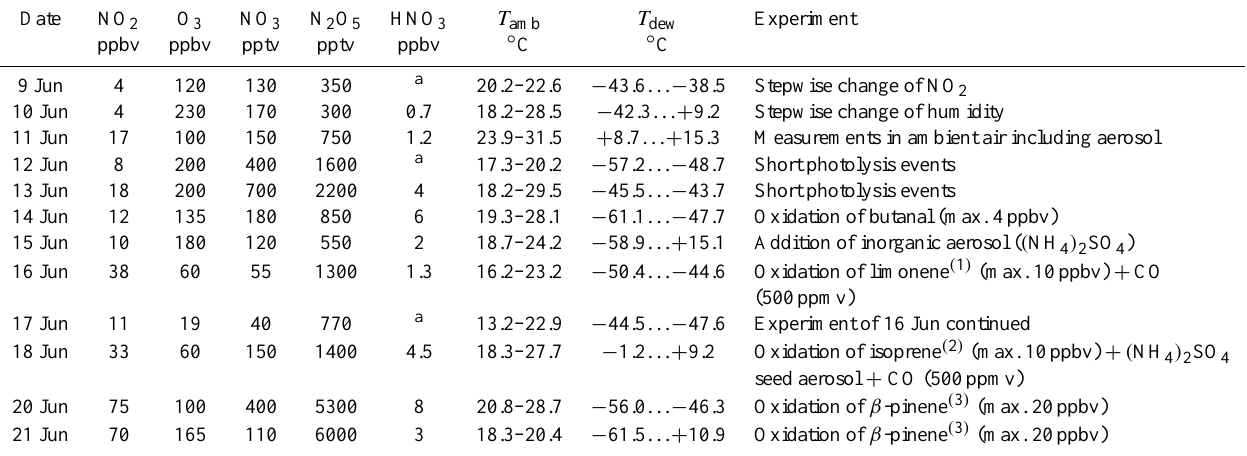
Table 1. List of experiments performed during NO3Comp. The mixing ratios of key constituents are maximum values measured during the experiments. Ambient and dew point temperature ranges are given as well as the experiments’